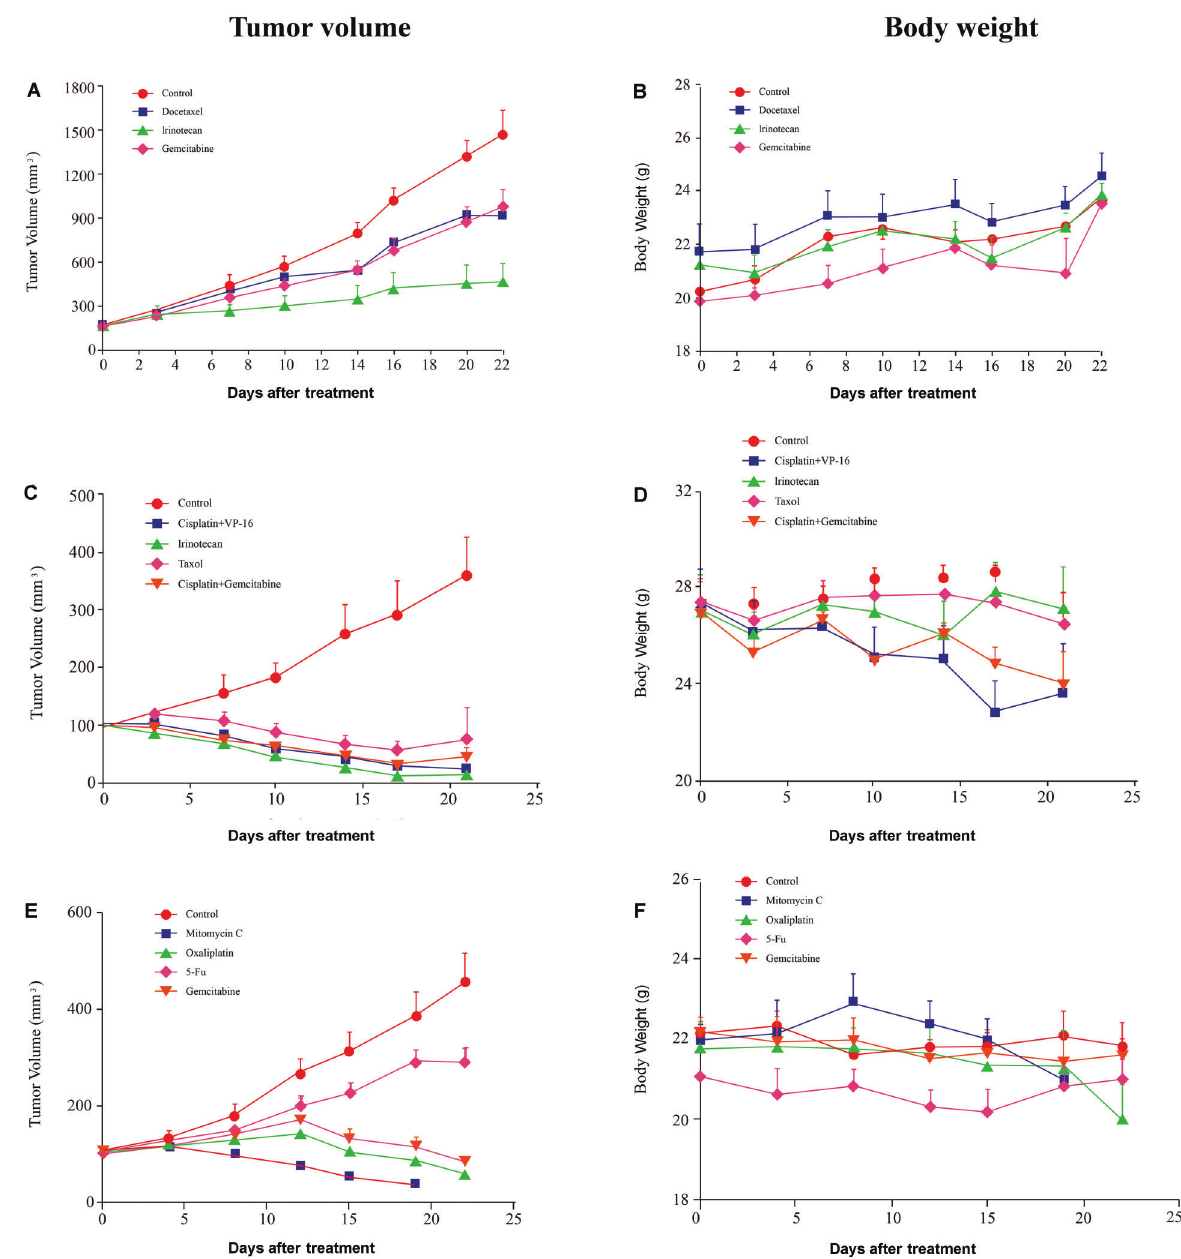
Figure 4. P2 tumor volume/time growth curves and mice body weight/time curves after the administration of chemotherapeutic drugs of patient-derived tumor xenograft (PDTX) small cell carcinoma (010000) ( A and B ), lung cancer (010026) ( C and D ) and adenocarcinoma (010027) ( E and